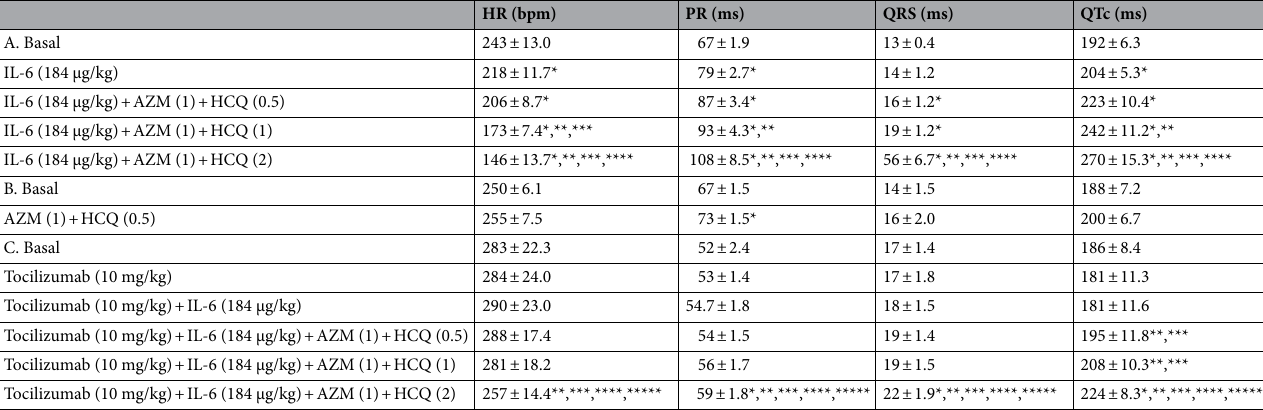
Table 1. In-vivo impact of the combination of IL-6, HCQ, AZM, and TCZ on guinea pig ECG. All values are expressed as mean ± SE, n = 6 guinea pigs for (A), n = 6 guinea pigs for (B) and n = 6 guinea pigs for (C). In panel (A), paired t-test was used to compare data before (basal) and after the drugs; each guinea pig is used as its own control. One-way repeated measures analysis of variance was used to compare data between the treatments with IL-6 alone and the combination with AZM and HCQ for HR, PR, QRS and QTc in the same group of guinea pigs. * p < 0.05 versus Basal; ** p < 0.05 versus IL-6 (184 μg/kg); *** p < 0.05 versus IL-6